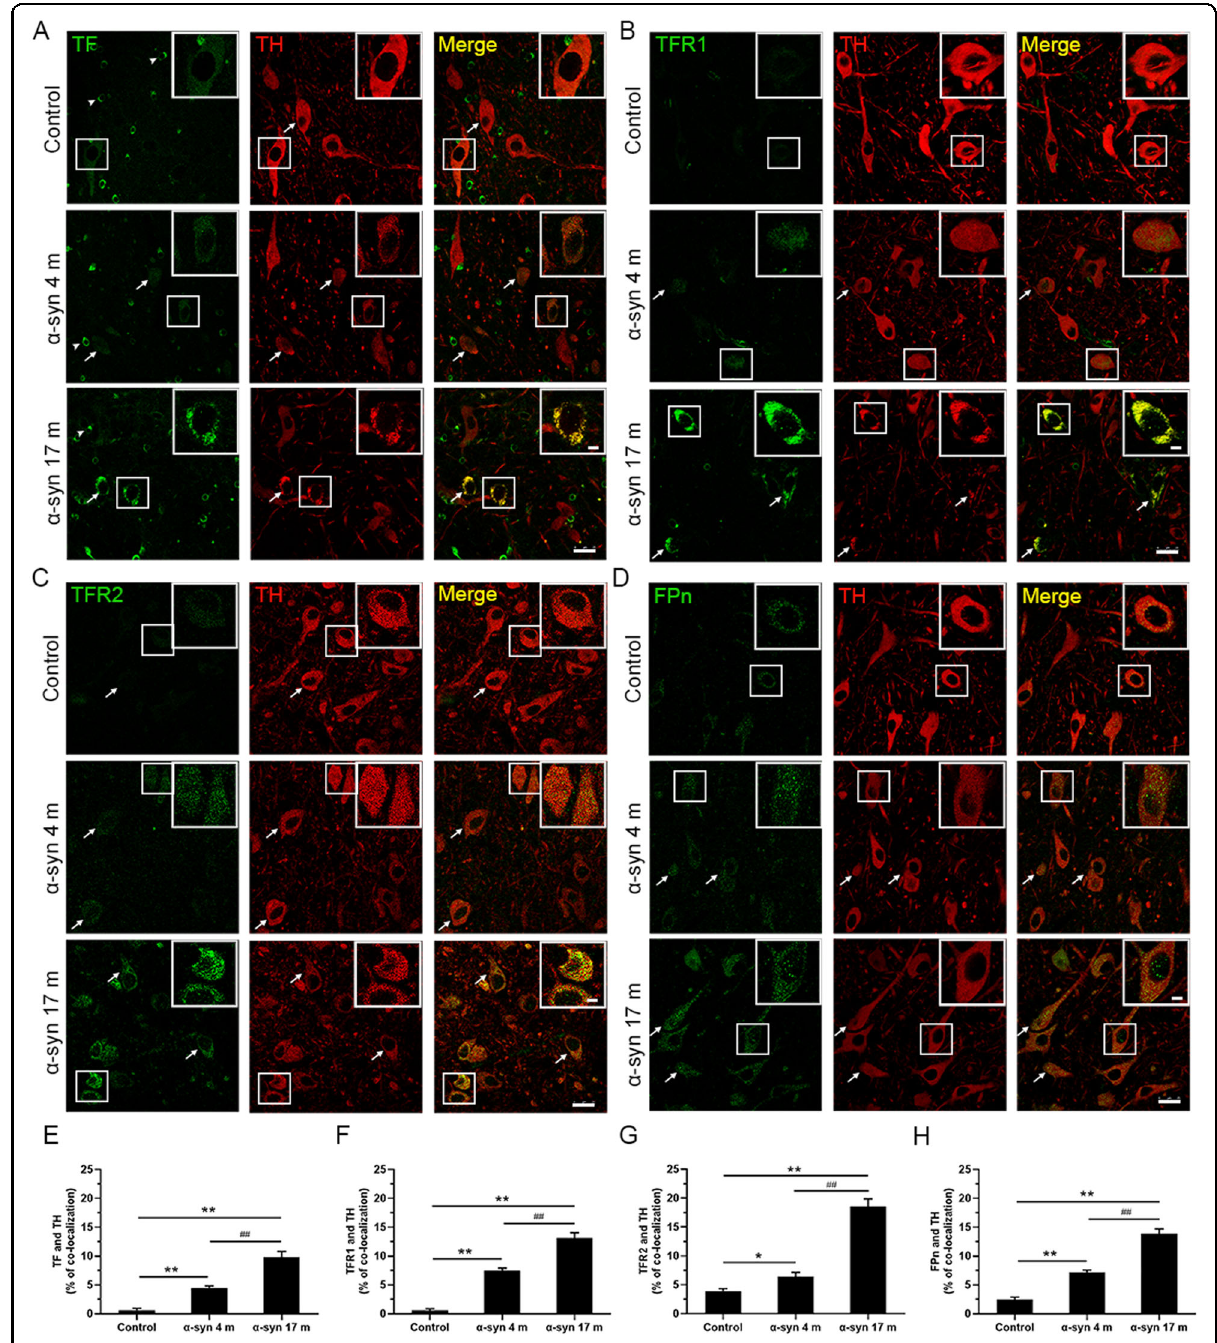
Fig. 7 Double fl uorescence images showing the colocalization of TF, TFR1, TFR2, FPn, and TH in dopaminergic neurons in the substantia nigra. A – D Immuno fl uorescence intensity of the TF-positive ( A ), TFR1-positive ( B ), TFR2-positive ( C ), and FPn-positive ( D ) signal increased, while the TH-positive signal decreased 4 and 17 months after α -syn PFFs treatments compared to the control. Arrows show colocalization of TF, TFR1, TFR2, FPn with TH in dopaminergic neurons. Arrowheads ( A ) show the presence of TF in oligodendrocytes. E – H Colocalizations of TF, TFR1, TFR2, FPn, and TH increased in the substantia nigra after α -syn PFFs treatment. α -Syn, α -synuclein; TF, transferrin; TFR1, transferrin receptor 1; TFR2, transferrin receptor 2; FPn, ferroportin. The data are presented as the mean ± SEM of three independent experiments. * p < 0.05 and ** p < 0.01 vs. control group, ## p < 0.01 vs. 4-month group, one-way ANOVA. Scale bars: 25 μ m in A – D